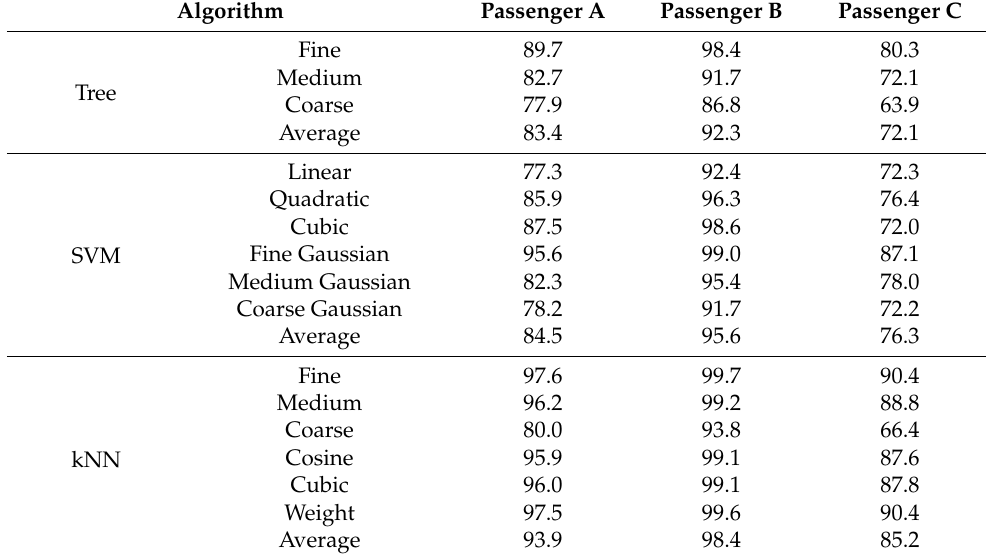
Table 3. Training accuracy of all passengers.